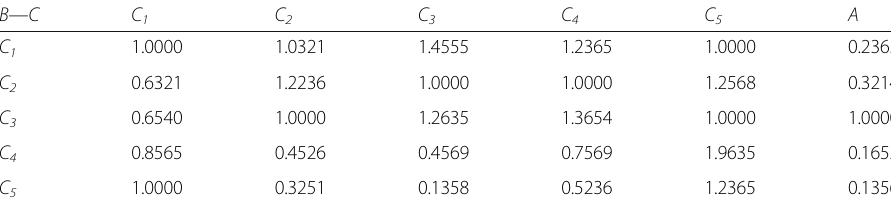
Table 2 Judgment matrix B - C